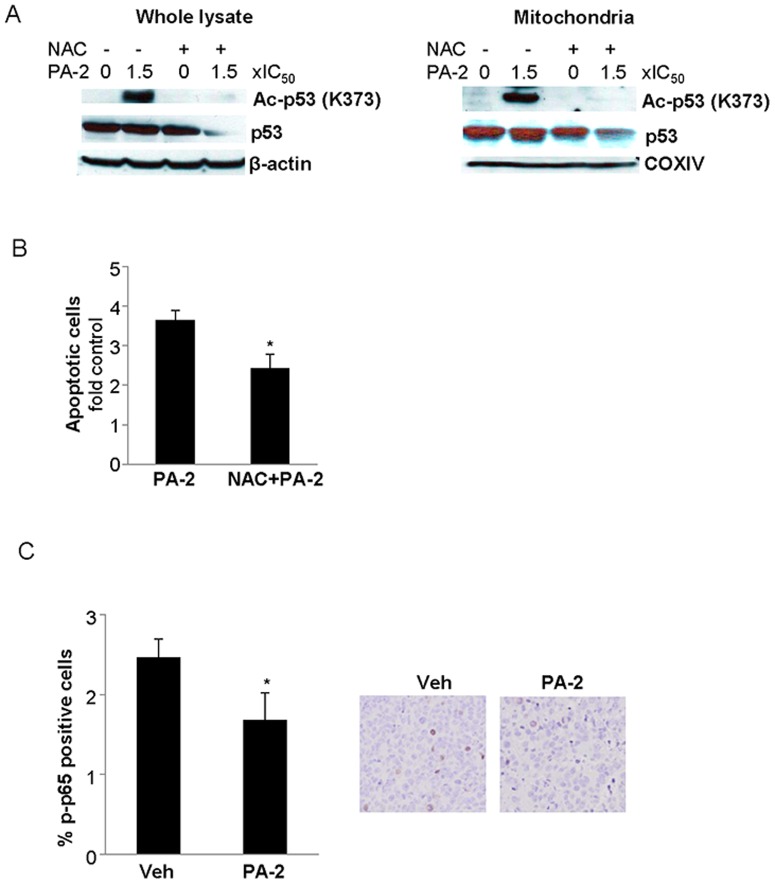
Induction of oxidative stress mediates the effect of phospho-aspirin-2 on p53.
A:
Left: Levels of total and acetylated p53 in MCF7 whole cell lysate after PA-2 treatment with or without 10 mM N-acetylcysteine. Right: Levels of total and acetylated p53 in MCF7 mitochondria after PA-2 treatment with or without 10 mM N-acetylcysteine. B: Co-incubation of PA-2 with N-acetylcysteine attenuated its apoptotic effect in MCF7 cells. C: Activated NF-kB (p-p65) levels from MCF7 tumors, determined by immunohistochemistry using anti-p-p65 antibody, were suppressed in PA-2-treated group compared with its vehicle group. The percentage of p-p65 positive cells in 10 fields was determined and averaged for each tumor. * P<0.05, compared to vehicle. Representative image are shown; magnification 200 x. All values are Mean ± SEM.